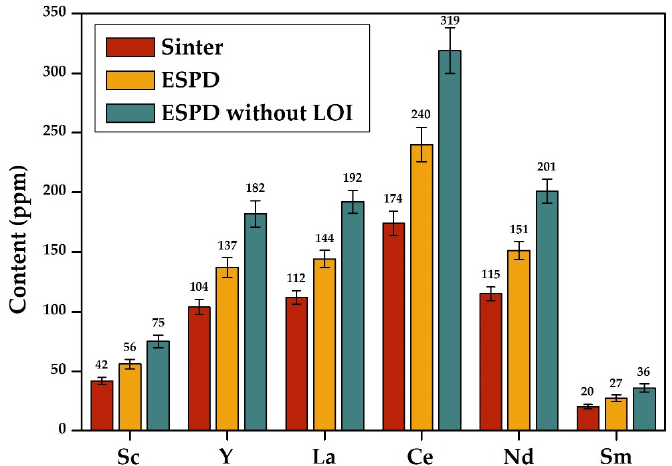
Figure 3. Content of rare earth elements in electrostatic precipitator dust and bauxite sinter, ppm (LOI—loss on ignition at 1000 ° С ).